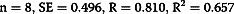
Synthesis of the target compounds 5a-k. Reagents and conditions: i) NaBH4, methanol, rt, 24 h; 60-78% yield ii) Appropriate carboxylic acid, EDCI HCl, DMAP, DCM, rt, 18 h, 28-86% yield.